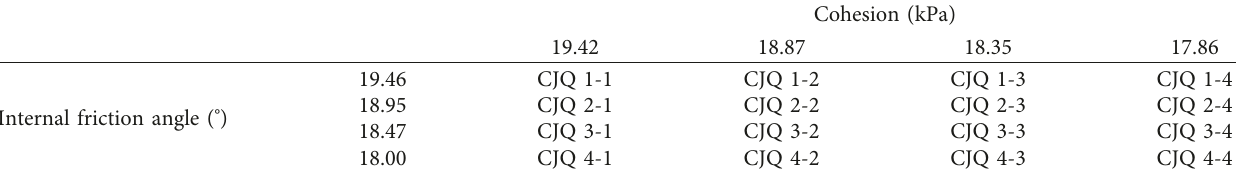
Table 3: Names of the 16 groups of c and ϕ for Cangjiangqiao landslide.